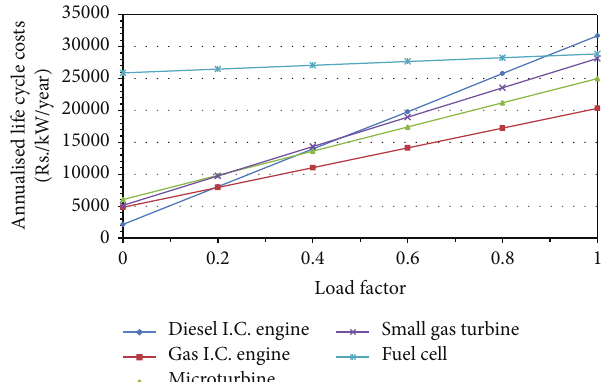
Figure 8: Comparison of annualised life cycle costs for different technological options when DG-CHP is considered (discount rate (𝑑) = 30 %) for the month of June 2011.